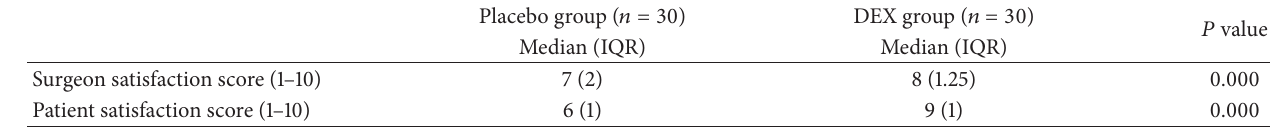
Table 5: Surgeon and patient satisfaction scores.